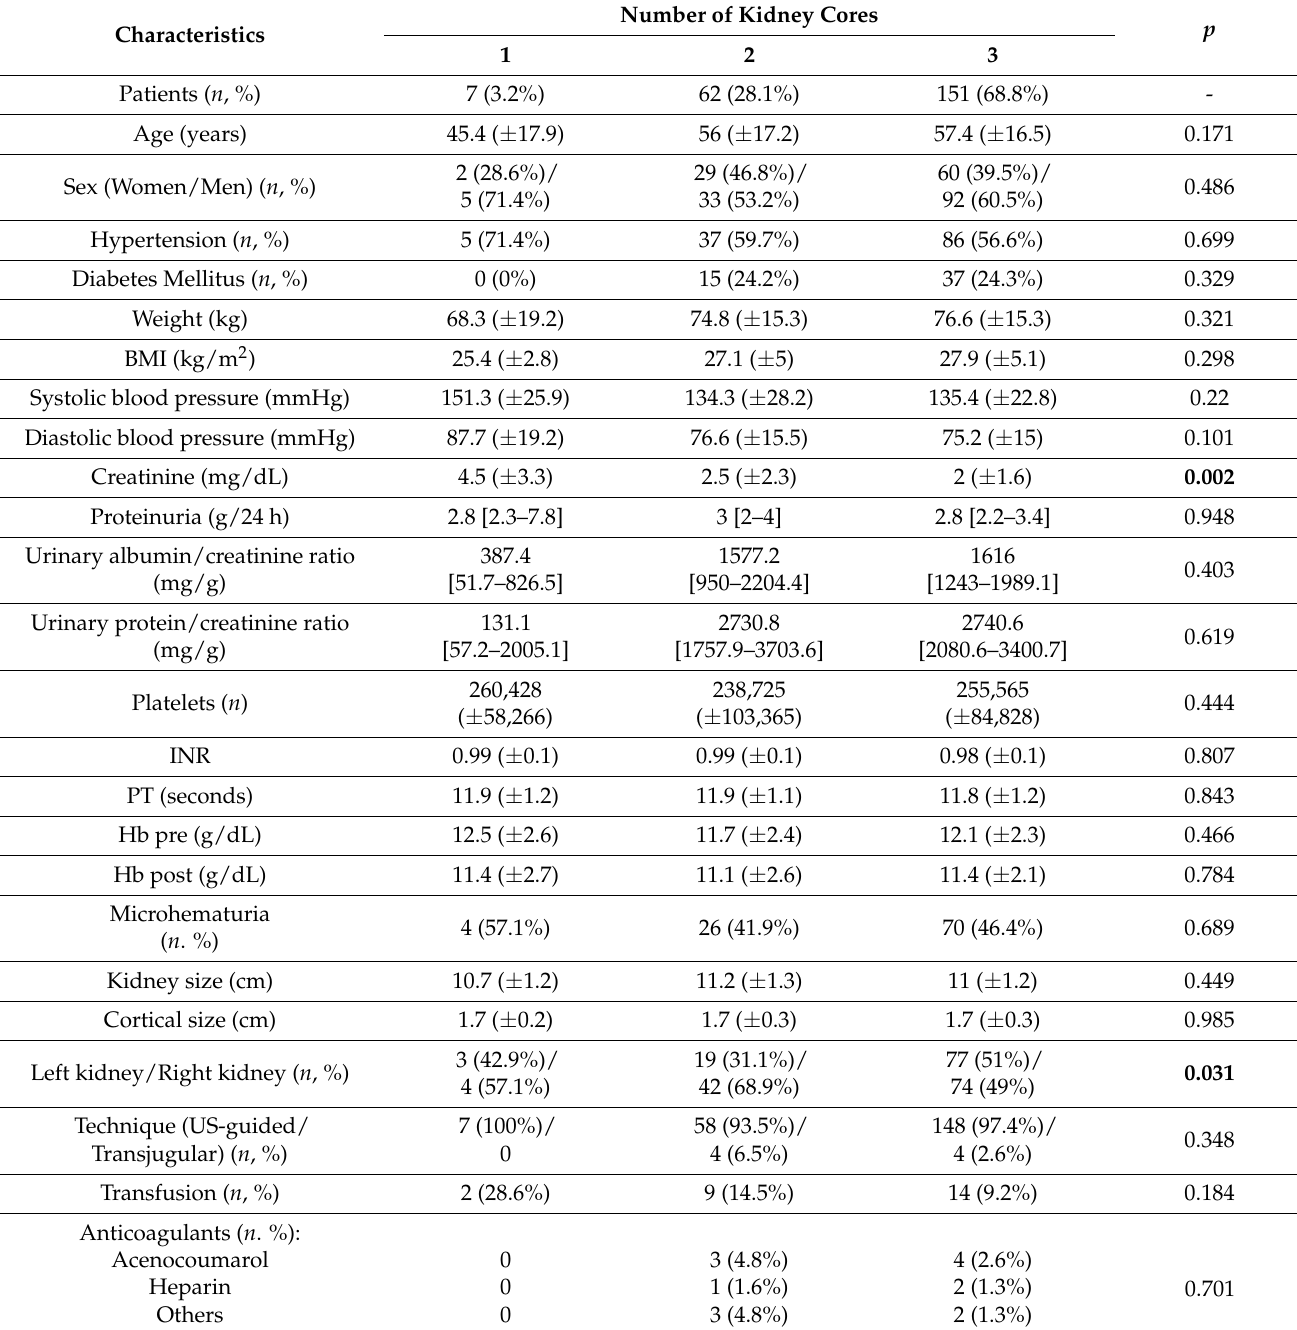
Table 3. Baseline characteristics population according with the number of kidney cores obtained at kidney